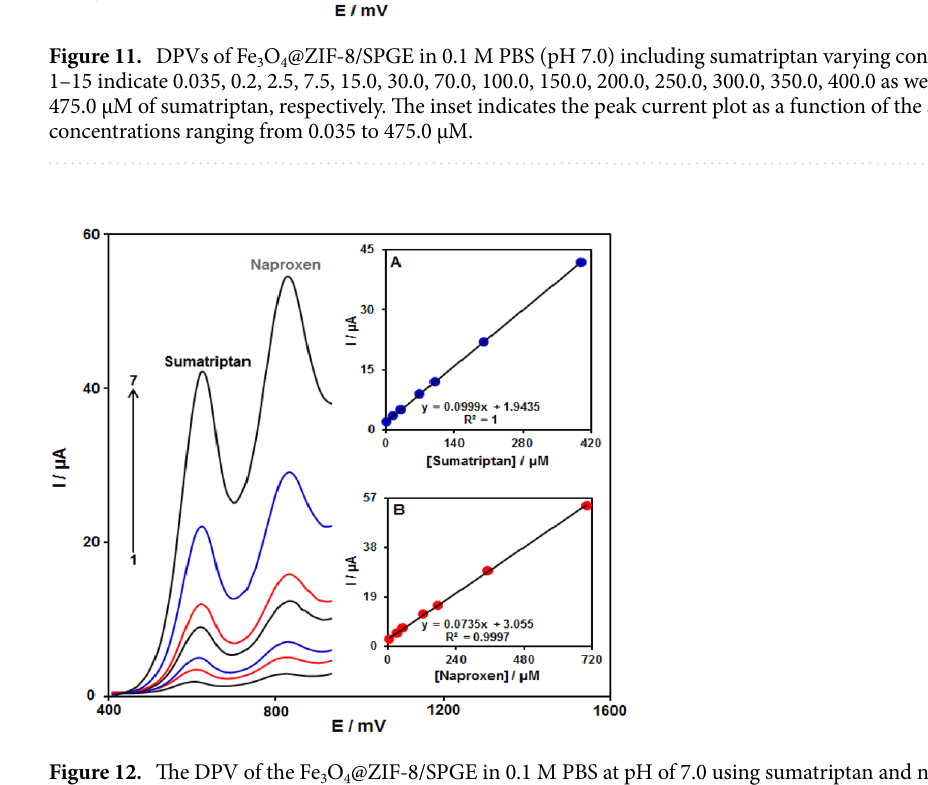
Figure 12. The DPV of the Fe 3 O 4 @ZIF-8/SPGE in 0.1 M PBS at pH of 7.0 using sumatriptan and naproxen varying concentrations. Accordingly, 1–7 relate to 2.5 + 5.0, 15.0 + 30.0, 30.0 + 50.0, 70.0 + 125.0, 100.0 +